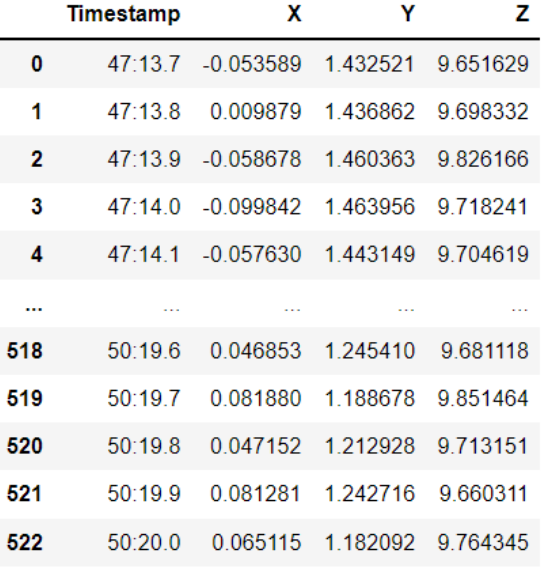
Figure 54. Orientation z - axis data, showing fluctuation between 3 and −4.